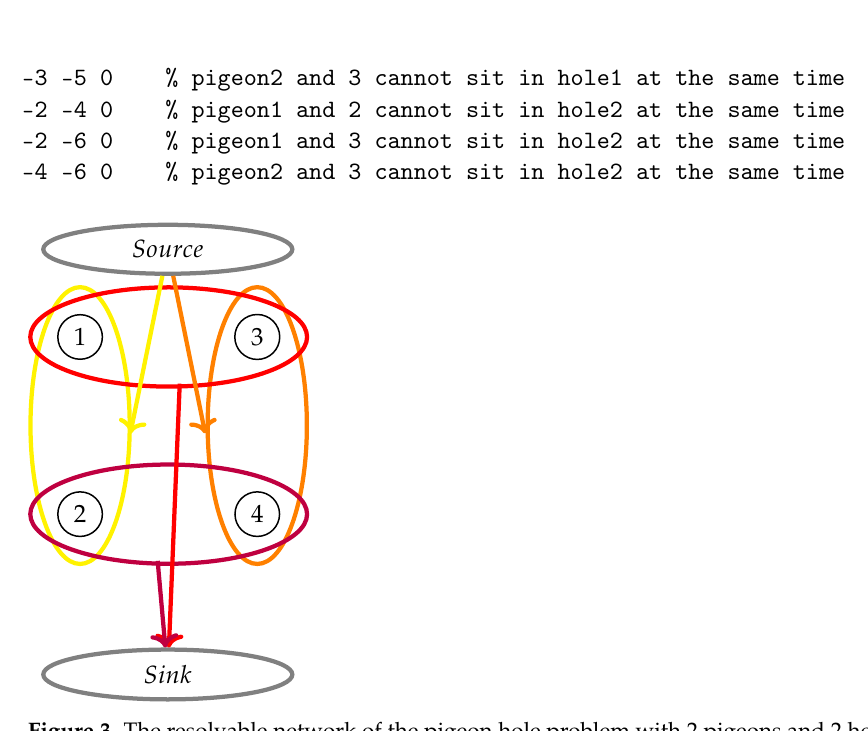
Figure 3. The resolvable network of the pigeon hole problem with 2 pigeons and 2 holes. This SAT problem is depicted in Figure 4. We use colors because there are many edges. For example, the light green edge connects the light green subnetwork to Sink .